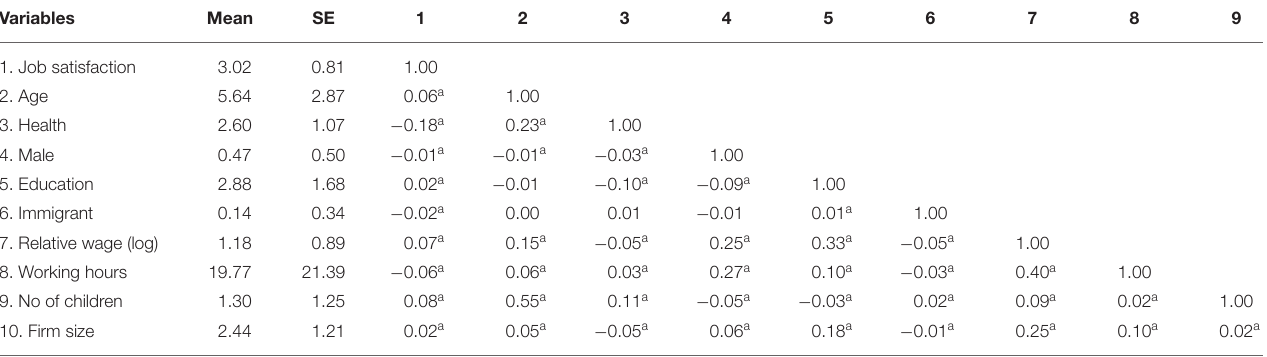
TABLE 1 | Means, standard errors and correlations between dependent and control variables. Variables